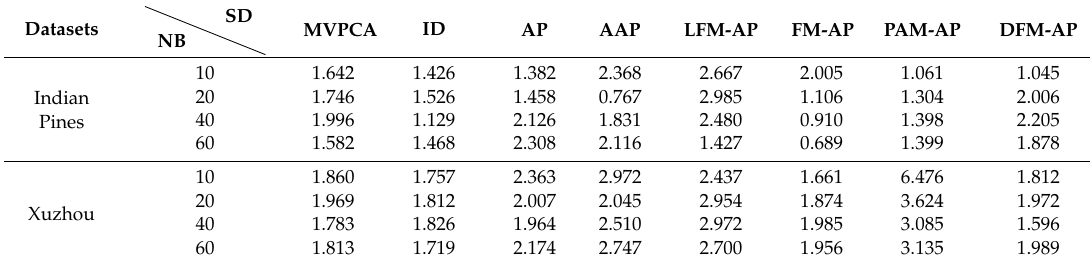
Table 2. SD of the seven compared methods and proposed DFM-AP compared to the number of selected bands (NB) in the range of 10–60 for the Indian Pines and Xuzhou datasets. Datasets